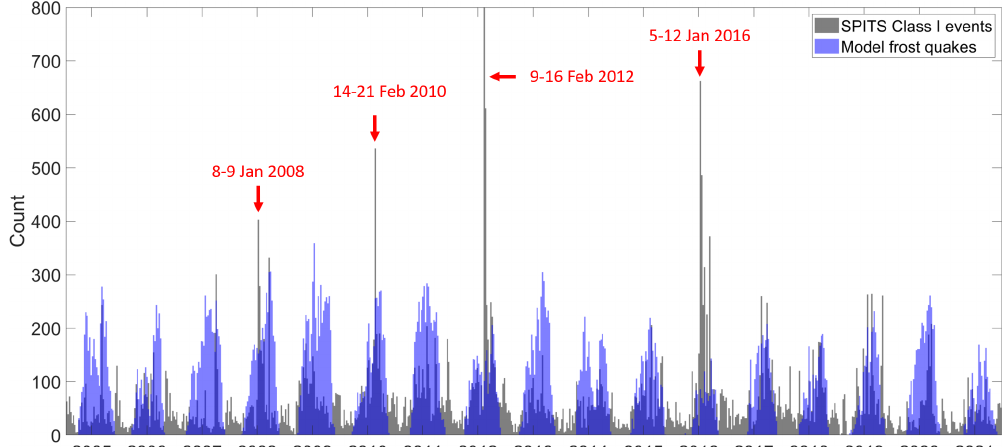
Figure 13. Histogram binned to 9d intervals comparing the modeled frost quake frequency (blue) with the recorded frequency of class I events (black). Anomalous spikes in seismicity following heavy-rainfall events (see Fig. B1) are annotated in red.